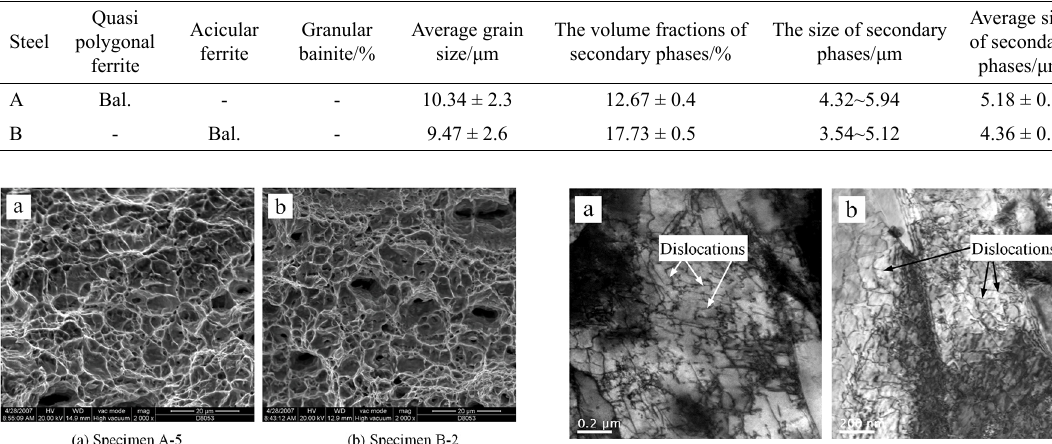
Table 3. Average grain size and the size and the volume fractions of secondary phases.